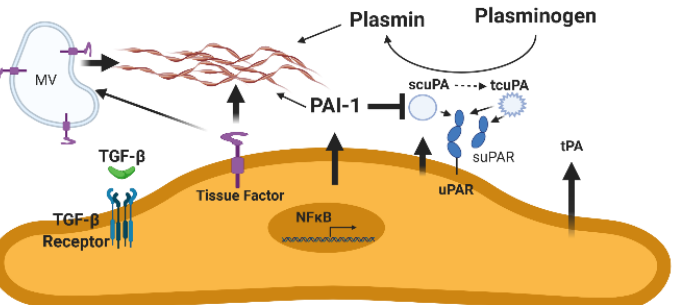
Figure 2. The mesothelium and disordered fibrin turnover. Increased TGF- β expression in response to injury increases plasminogen activator inhibitor-1 (PAI-1) expression. In the aggregate, PAI-1 expression and activity are overexpressed in exudative pleural effusions. This increase in PAI-1 reduces plasminogen conversion to active plasmin by single chain urokinase plasminogen activator (scuPA), two chain urokinase plasminogen activator (tcuPA), and tissue plasminogen activator (tPA). These effects decrease local expression of fibrinolytic activity, which decreases fibrin degradation, leading to aberrant extravascular fibrin deposition. scuPA or the high molecular weight form of tcuPA can bind uPA receptor (uPAR) and be localized to the cell surface or be present unbound in pleural fluids. NFκB is NF kappa B, a signaling mediator that is in particular implicated in the transcriptional regulation of PAI-1 expression by pleural mesothelial cells. MV is microvesicles, which have been shown to contain TF. Brown strands indicate fibrin.